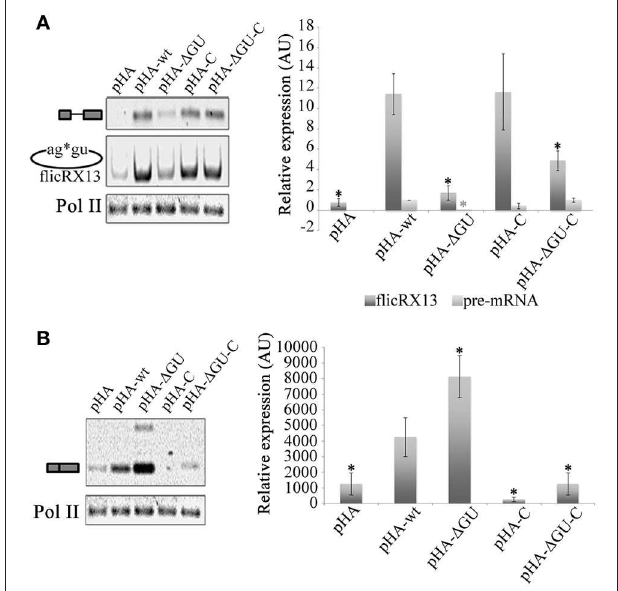
FIGURE 5 | The GU-rich 5 ′ ss element of the intron is involved in flicRNA biogenesis and function. Amoeba transformants expressing wt, 5 ′ ss mutant (GUUUGUUU to GUAAGAA), C-enriched BP mutant (AACTAACTTTT A to ACCTCCCTCTT A ; A in bold corresponds to the BP mapped in Figure S1 ), and double mutant RabX13 minigene constructs were established, and the impact on unspliced, spliced, and flicRX13 RabX13 variant expression was assessed by qRT-PCR using primers CS + 116 and Rab-REx2 targeted to plasmid sequences (A) and endogenous RabX13 mRNA (B) . Decreases of plasmid-derived unspliced RabX13 variants and flicRX13 were statistically significant; likewise, the increase of endogenous mRNA was statistically significant (ANOVA black asterisk P ≤ 0.0001, gray asterisk P ≤ 0.01, respectively). Values are the average of three independent